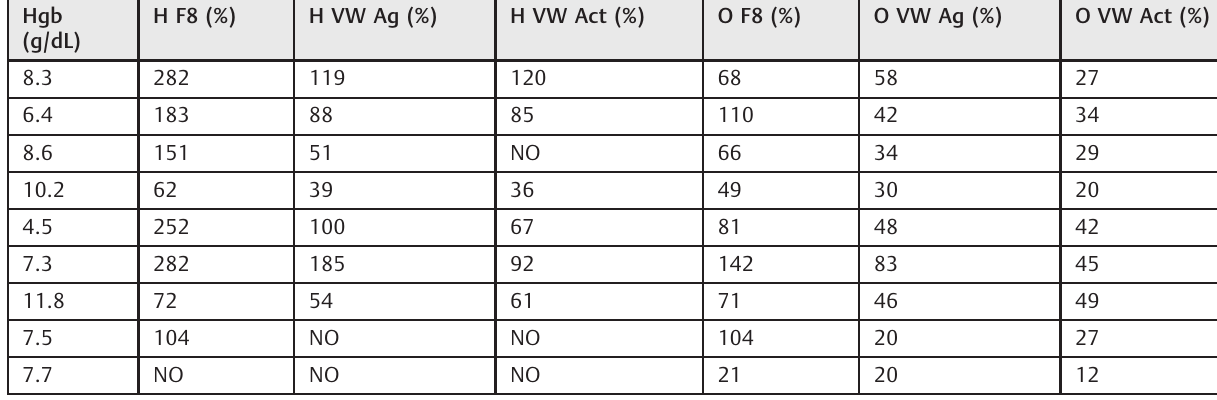
Table 2 Diagnostic VWD laboratory data for patients with HMB and diagnosed with VWD